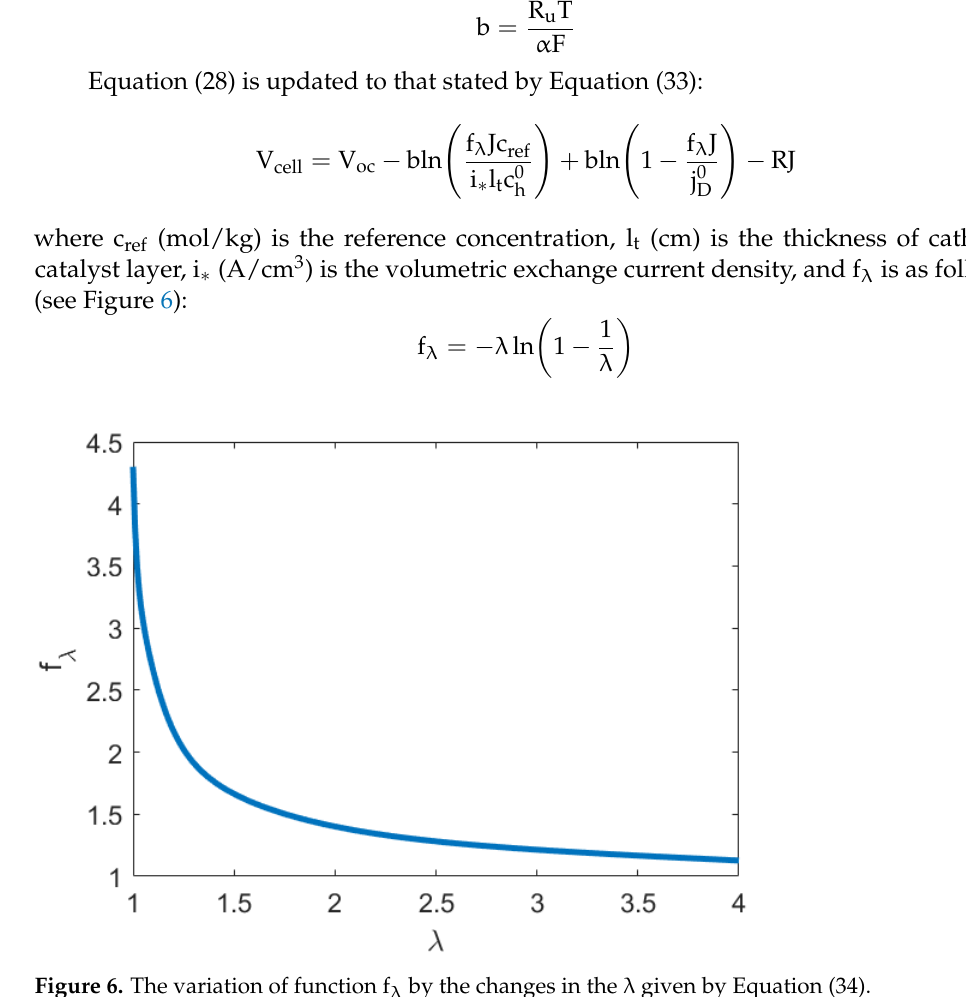
Figure 6. The variation of function f λ by the changes in the λ given by Equation (34).